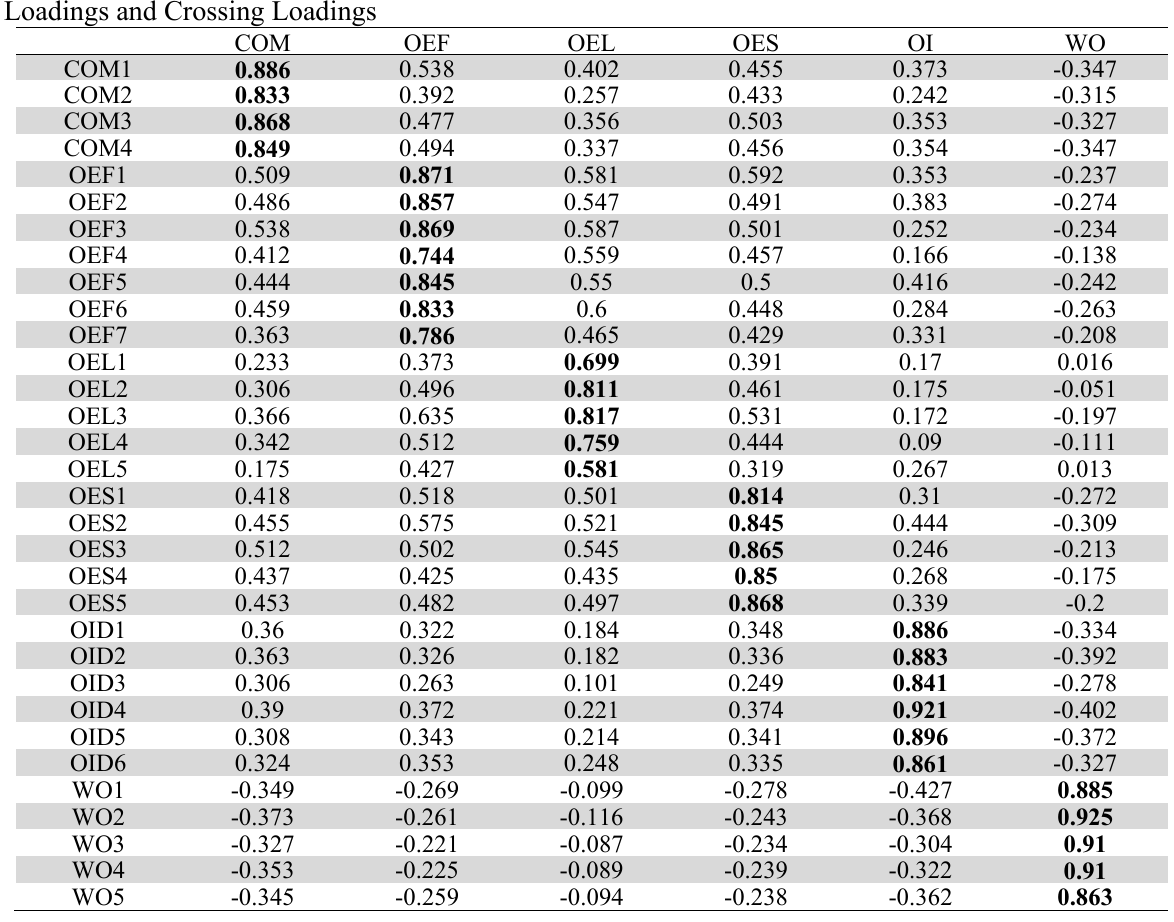
Loadings and Crossing Loadings